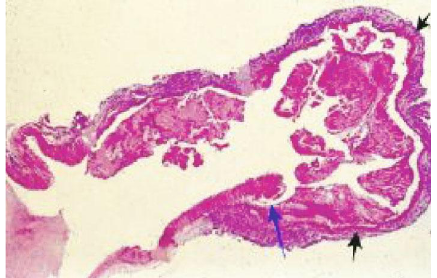
Figure 26: Vertebral artery dissection. The black arrow points to a gap aneurysm and the blue arrow to a beginning dissection. Hematoxylin & eosin ×